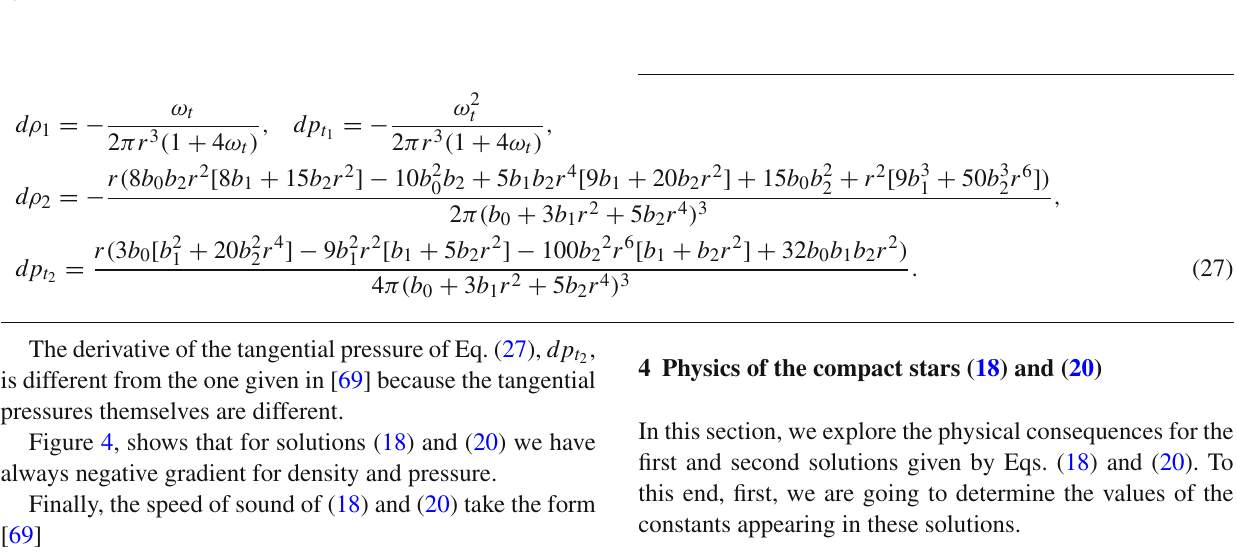
( a ) Mass of solution (18) against radial (b) Mass of solution (20) against radial (c) Compactness parameter of solution (20) coordinate coordinate against radial coordinate Fig. 3 Schematic plot of the gravitational mass of solutions (18) and (20) and compactness parameter versus the radial coordinate r in km when b 0 = 0 . 0001 and b 1 = 0 .